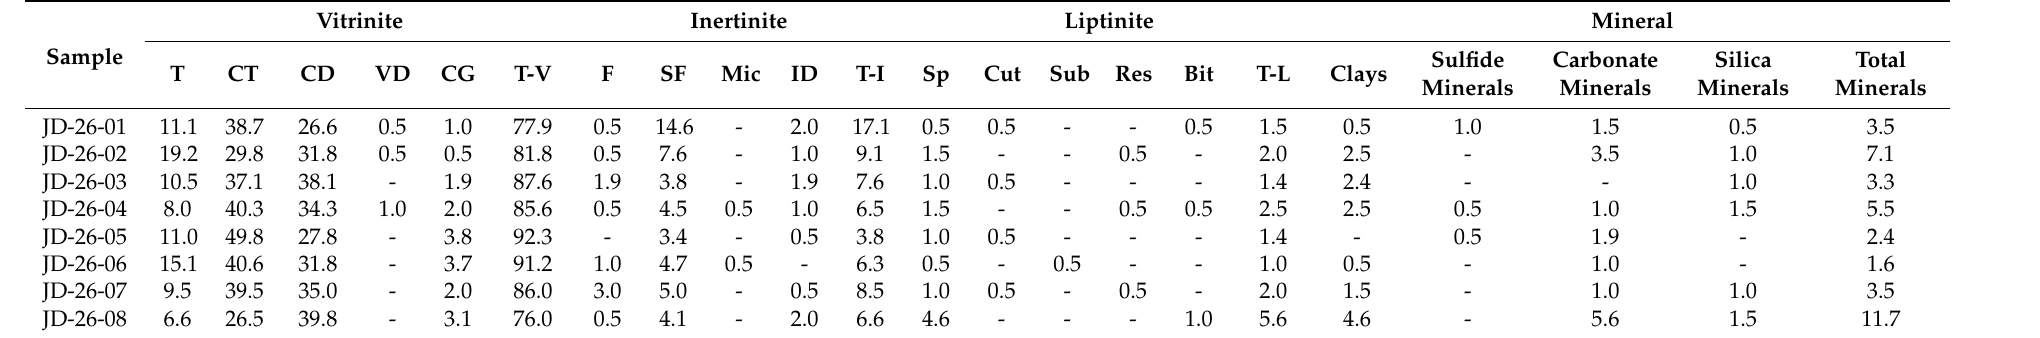
Table 2. Coal petrology characteristics of No. 26 coals